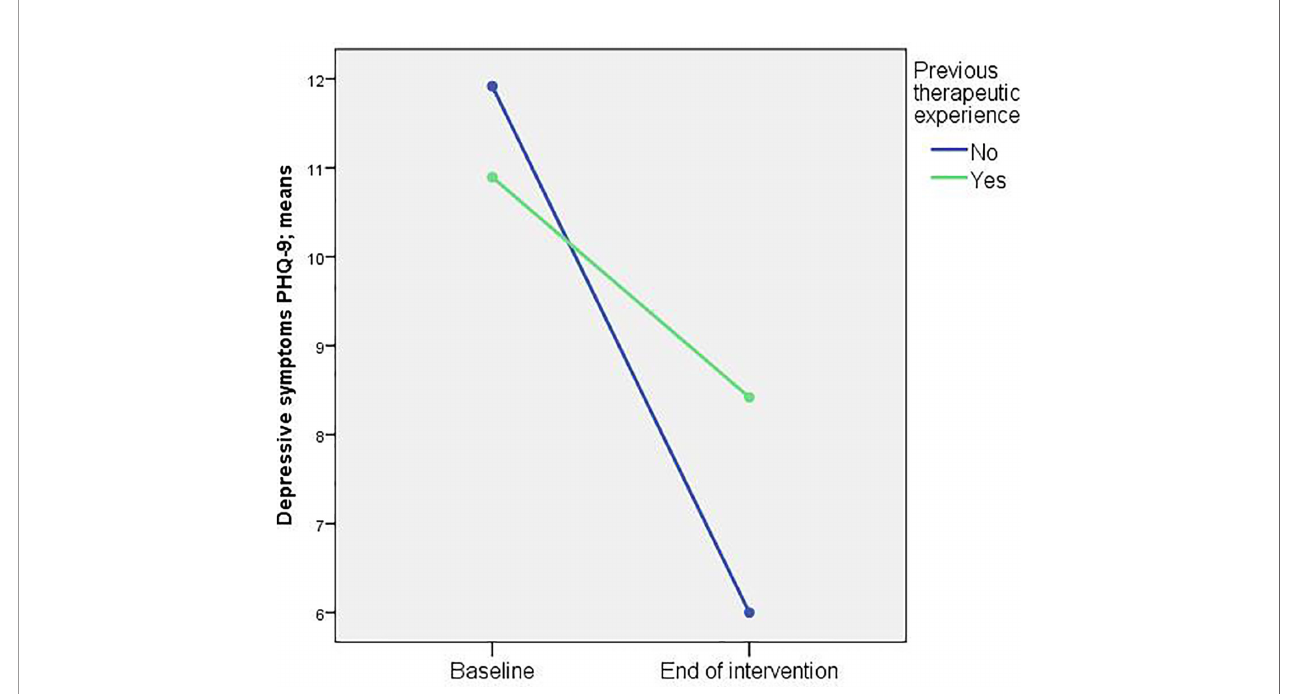
FIGURE 2 | Changes in depressive symptoms strati fi ed by previous psychotherapeutic/psychiatric experience (n = 62).